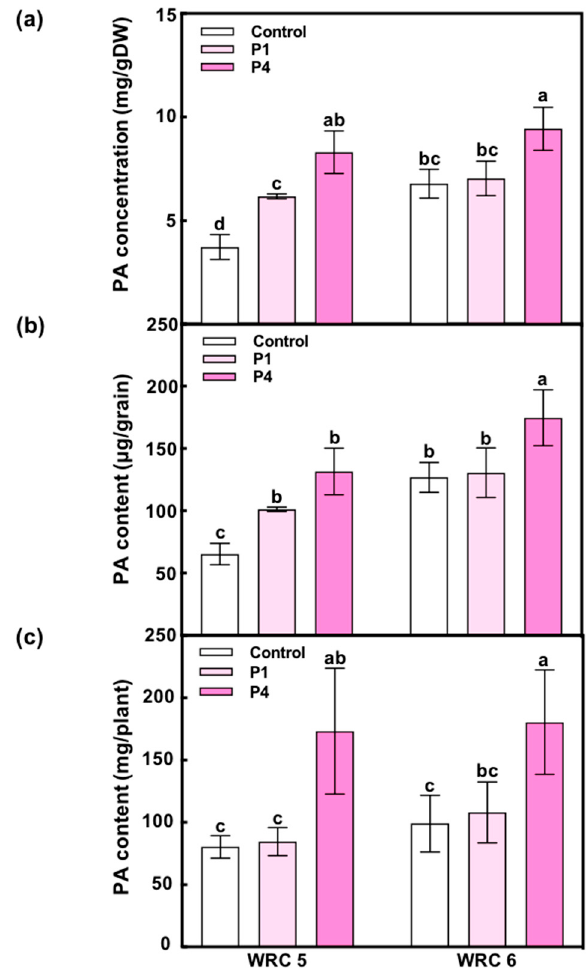
Figure 2. Effect of the amount of P fertilizer on PA accumulation in WRC 5 and WRC 6. ( a ) PA concentration per gram dry weight (mg/gDW), ( b ) PA content per grain ( μ g/grain), ( c ) PA content per plant (mg/plant). White, pale pink, and pink indicate control, P1 treatment, and P4 treatment, respectively. Each value represents the mean ± SD of four replicates. Different letters indicate statistical differences (Tukey’s HSD test, p < 0.05).